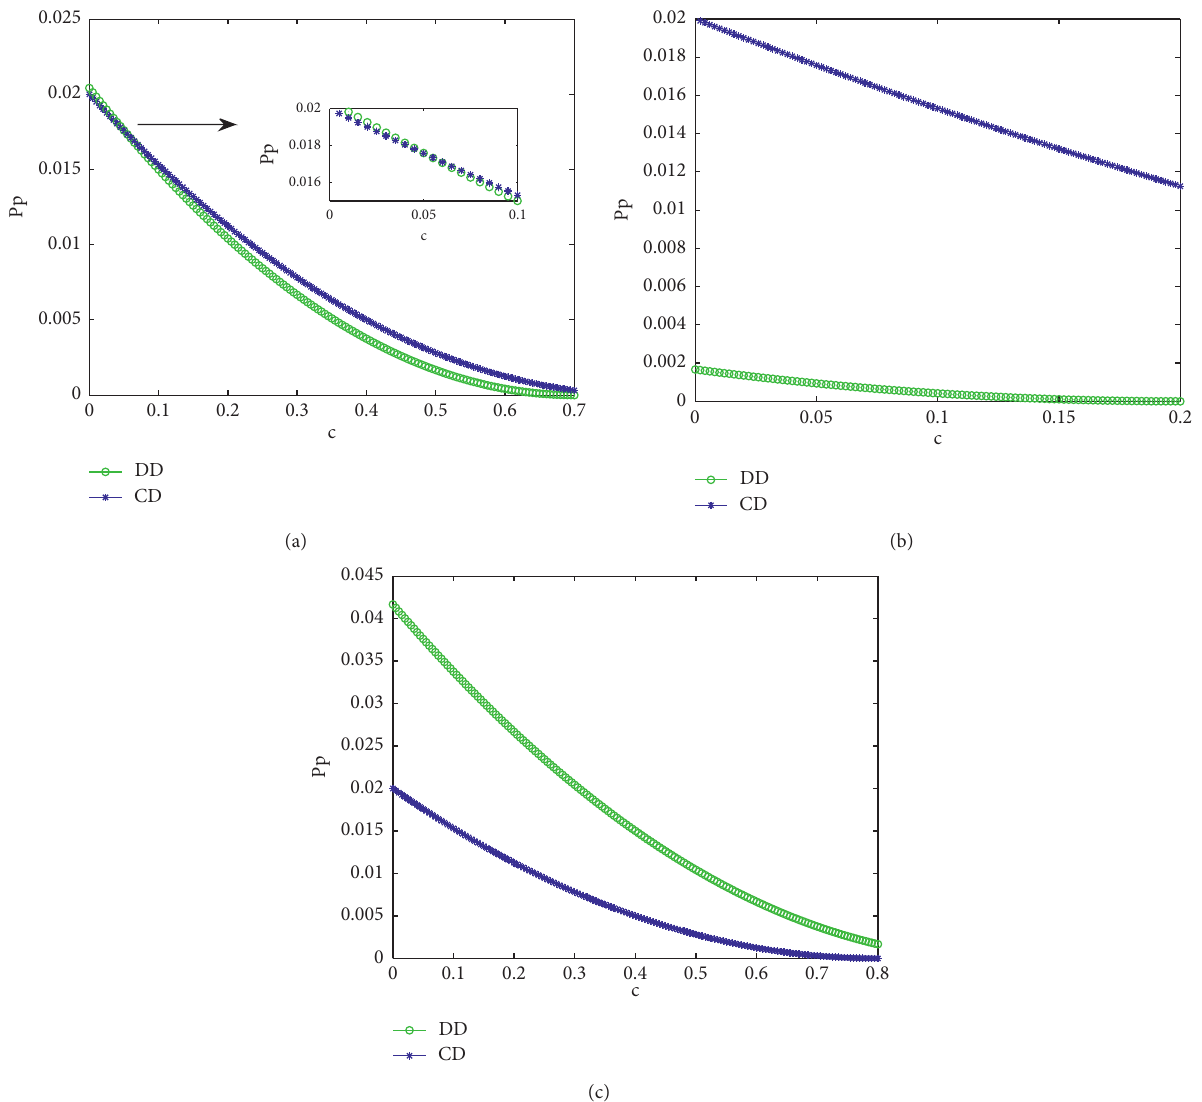
Figure 3: Profit comparison: (a) a � 1 . 5 and k � 0 . 2; (b) a � 2 . 0 and k � 0 . 2; and (c) a � 1 . 2 and k � 0 .